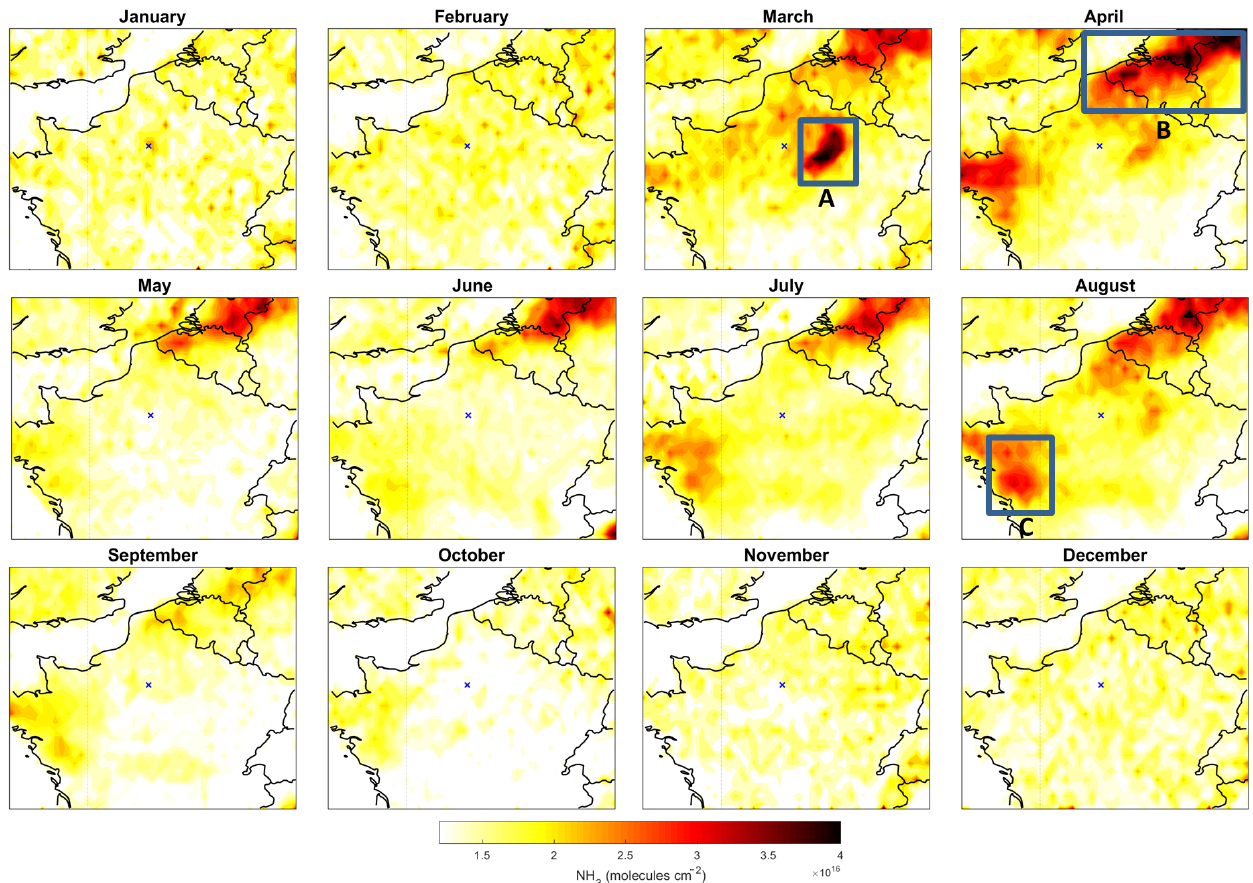
Figure 3. Monthly means of NH 3 total columns (moleculescm − 2 ) derived from 5 years (2013–2017) of CrIS NH 3 -retrieved columns. The blue cross indicates the location of